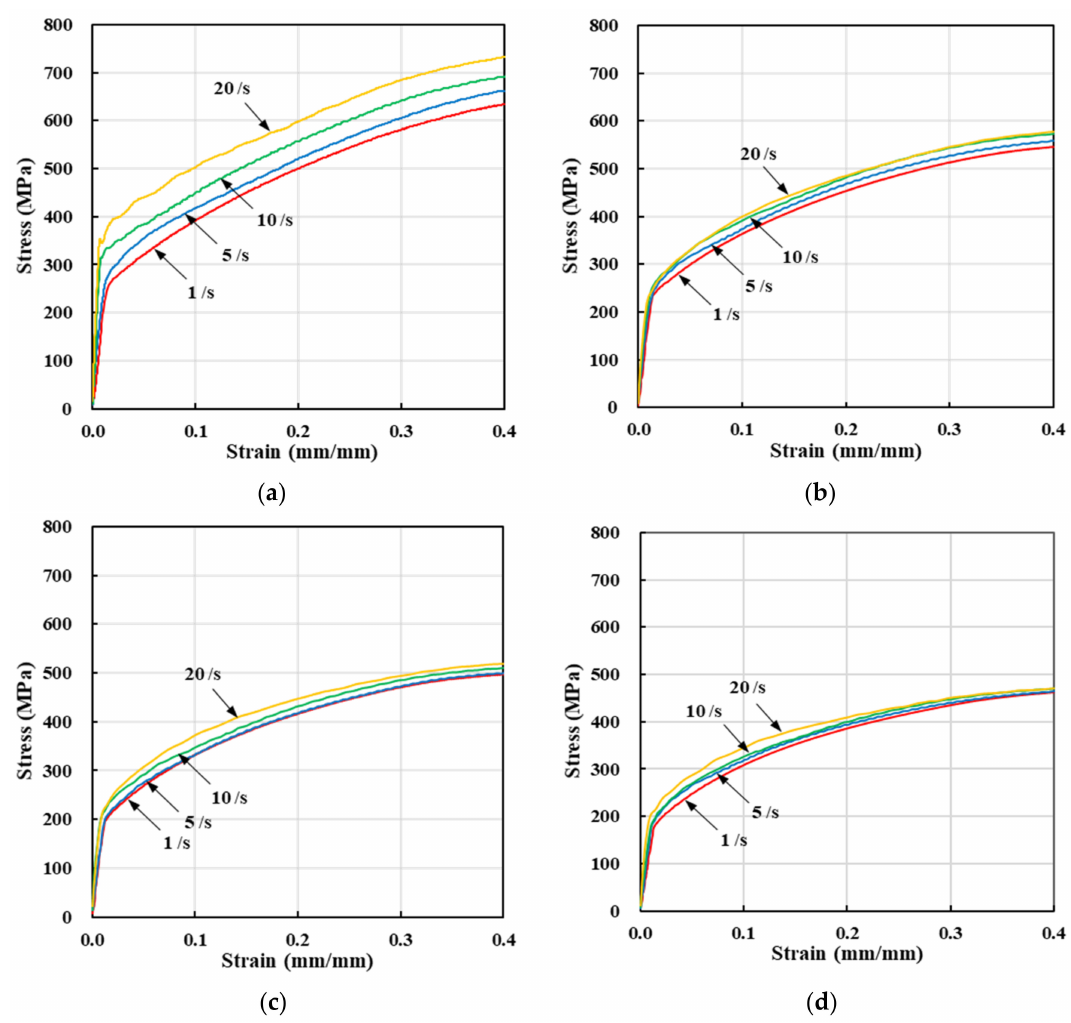
Figure 4. Flow stresses yielded by compression tests at various sample temperatures and strain rates: